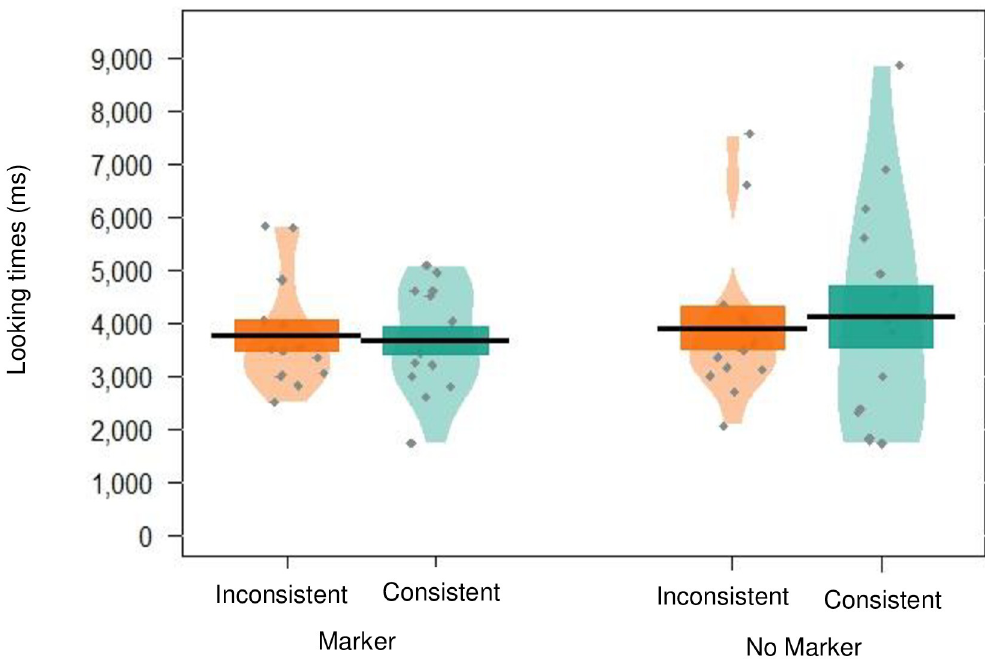
Fig 3. Pirate plot depicting the (raw) mean looking times to trials containing words from the same ( consistent ) versus different ( inconsistent ) categories for participants in experiment 1, given for each condition. Black lines indicate the mean, and the coloured blocks indicate SE . The distribution of looking times is given for each group, with individual data points in grey.